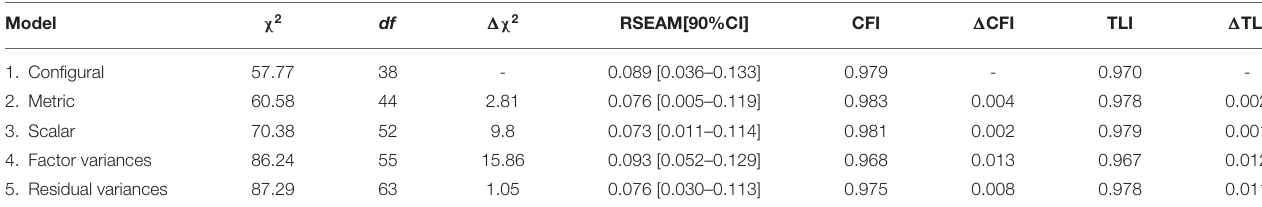
TABLE 2 | Measurement invariance tests of the 6-factor